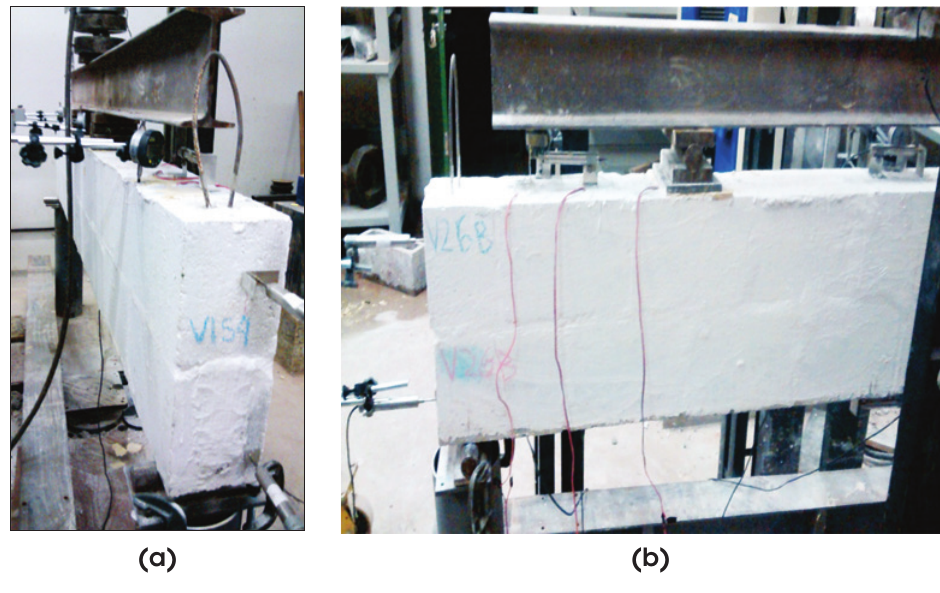
Testing typical instrumentation – LVDT and Displacement